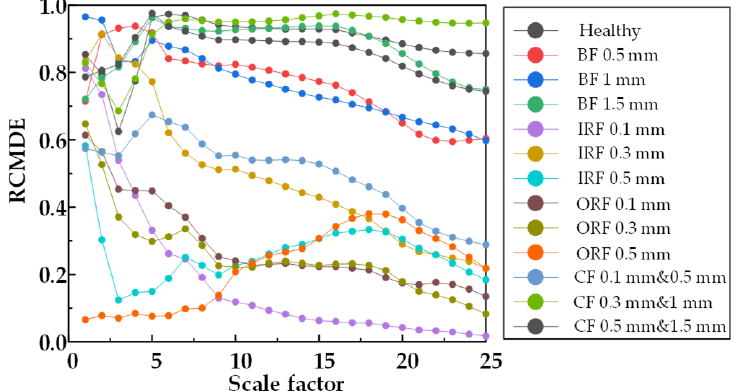
Figure 21. RCMFE entropy values of 25 scale factors under different damage degrees.